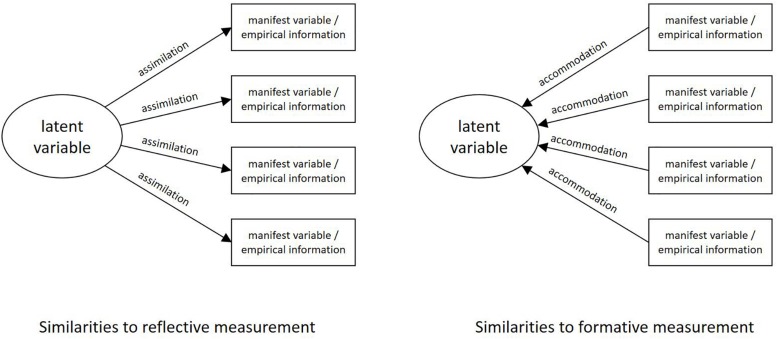
Similarities to reflective and formative measurements according to Edwards and Bagozzi (2000).